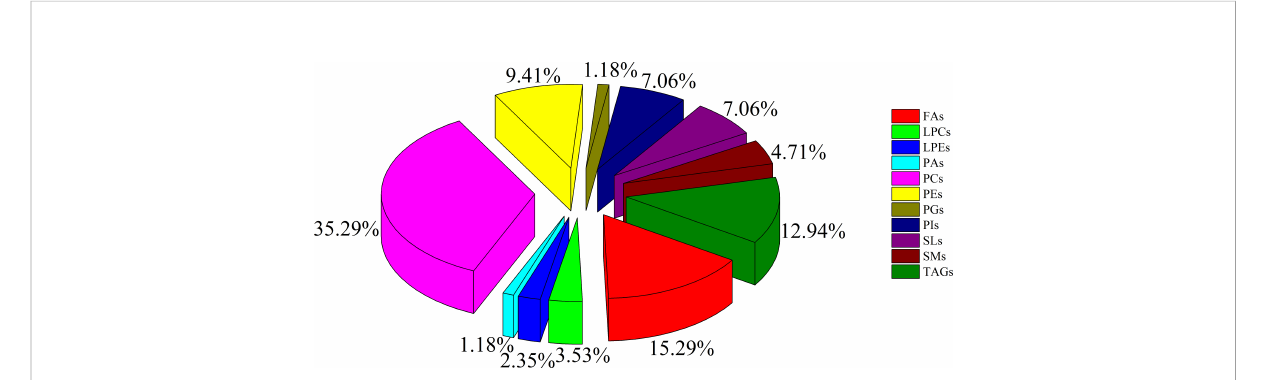
FIGURE 3 The constituent ratio of serum differential lipid species between CA and CRC groups. Abbreviations: TAG, triacylglycerol; FA, fatty acid; LPC, lysophosphatidylcholine; PG, phosphatidylglycerol; PC, phosphatidylcholine; PE, phosphatidylethanolamine; SM, sphingomyelin; LPE, lysophosphatidylethanolamine; PA, phosphatidic acid; SL, sphingolipid; PI,